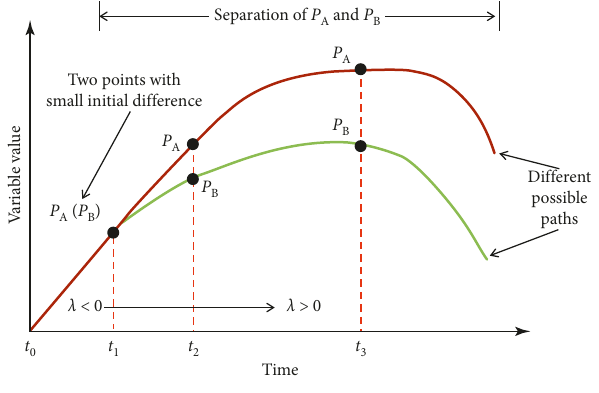
Figure 1: Schematic drawing of